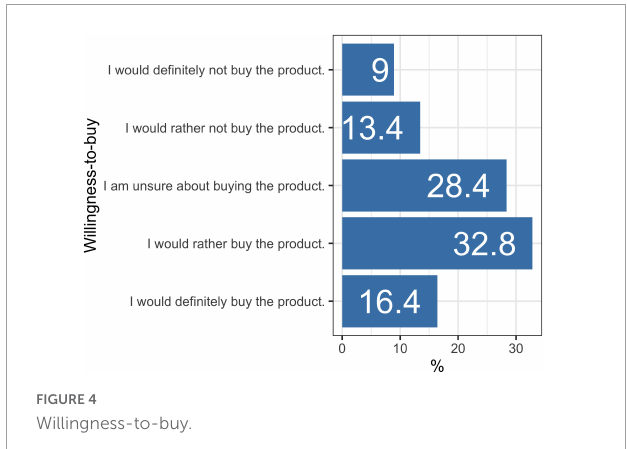
FIGURE4 Willingness-to-buy.